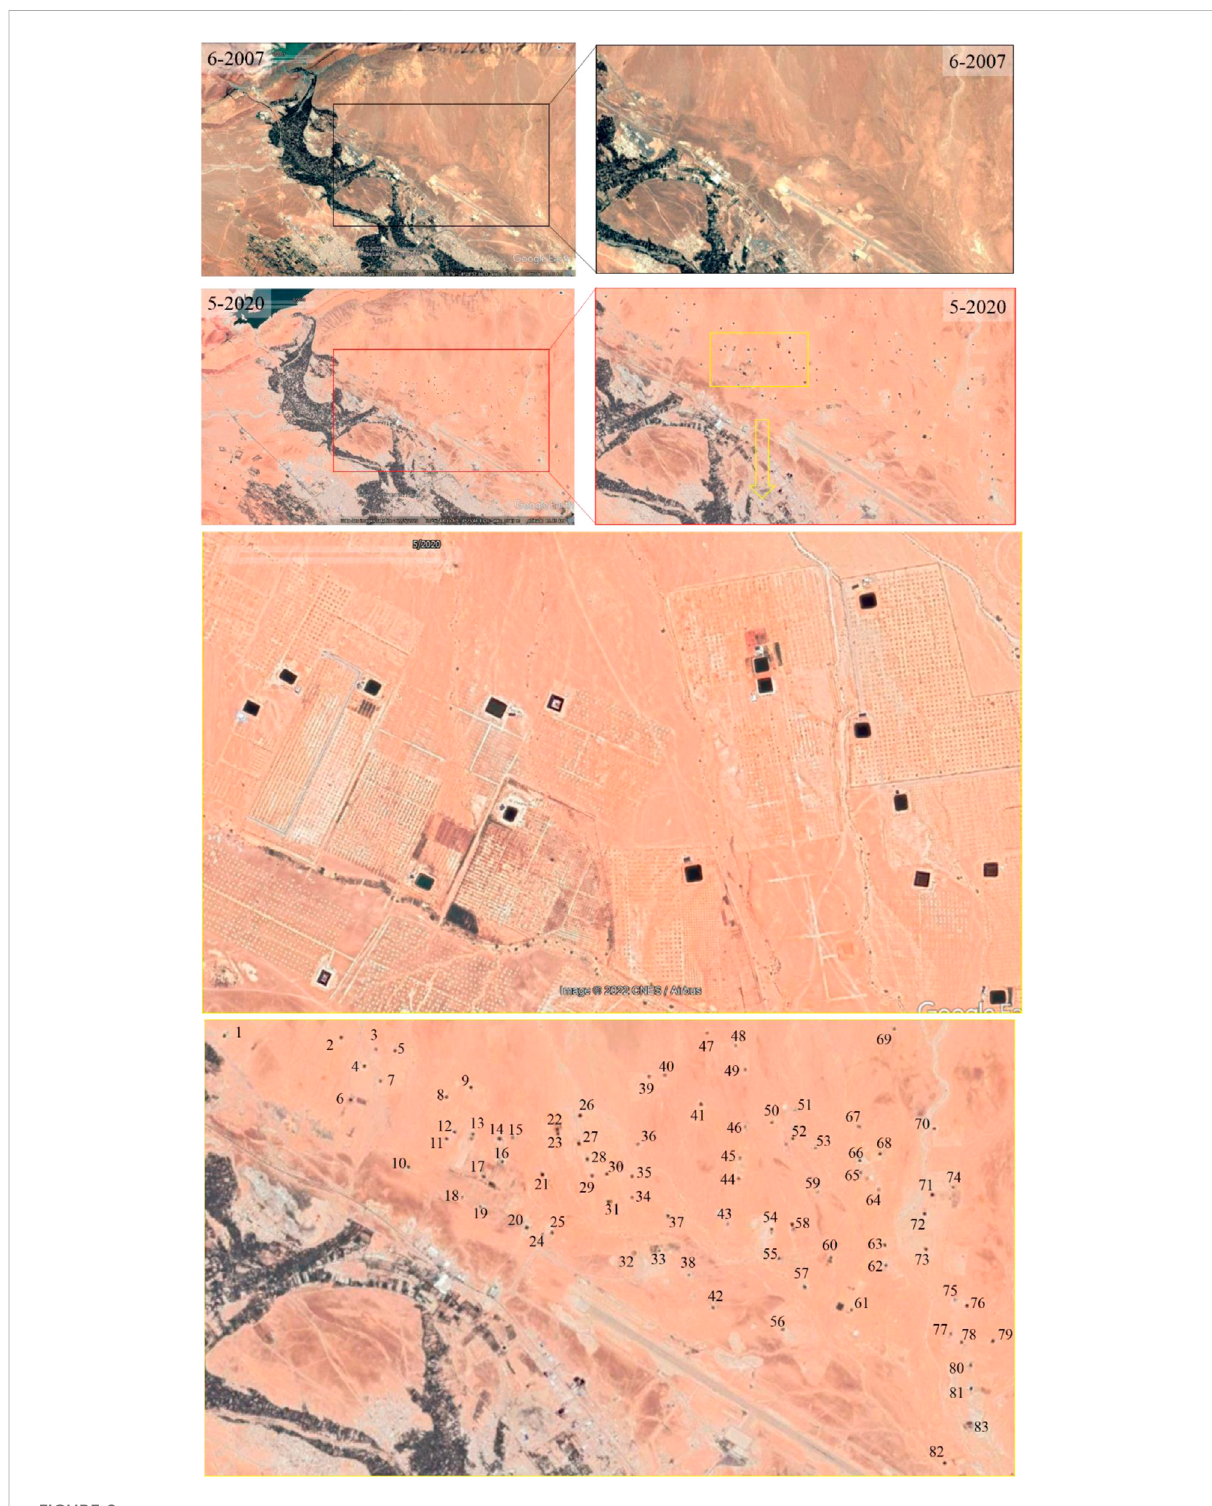
FIGURE 8 Change of the buildup area of Errachidia city in 2 years 2007 and 2020 using Google Earth